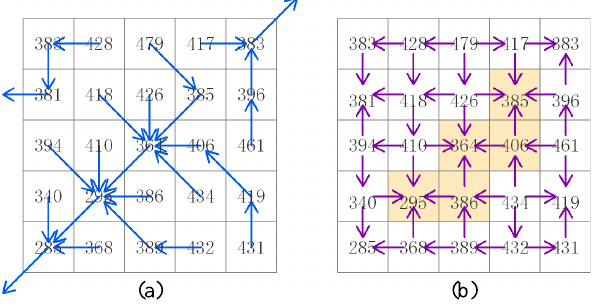
Fig. 2. Overland flow paths processed by D8 and MIKE